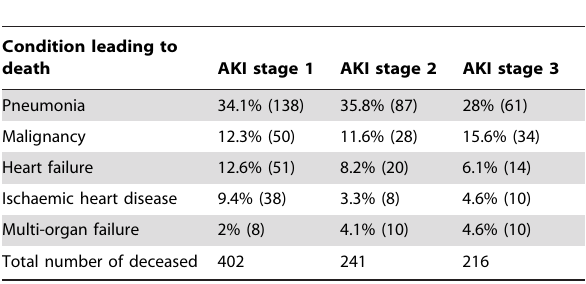
Table 2. Table of the most frequent primary cause of death stratified by AKI